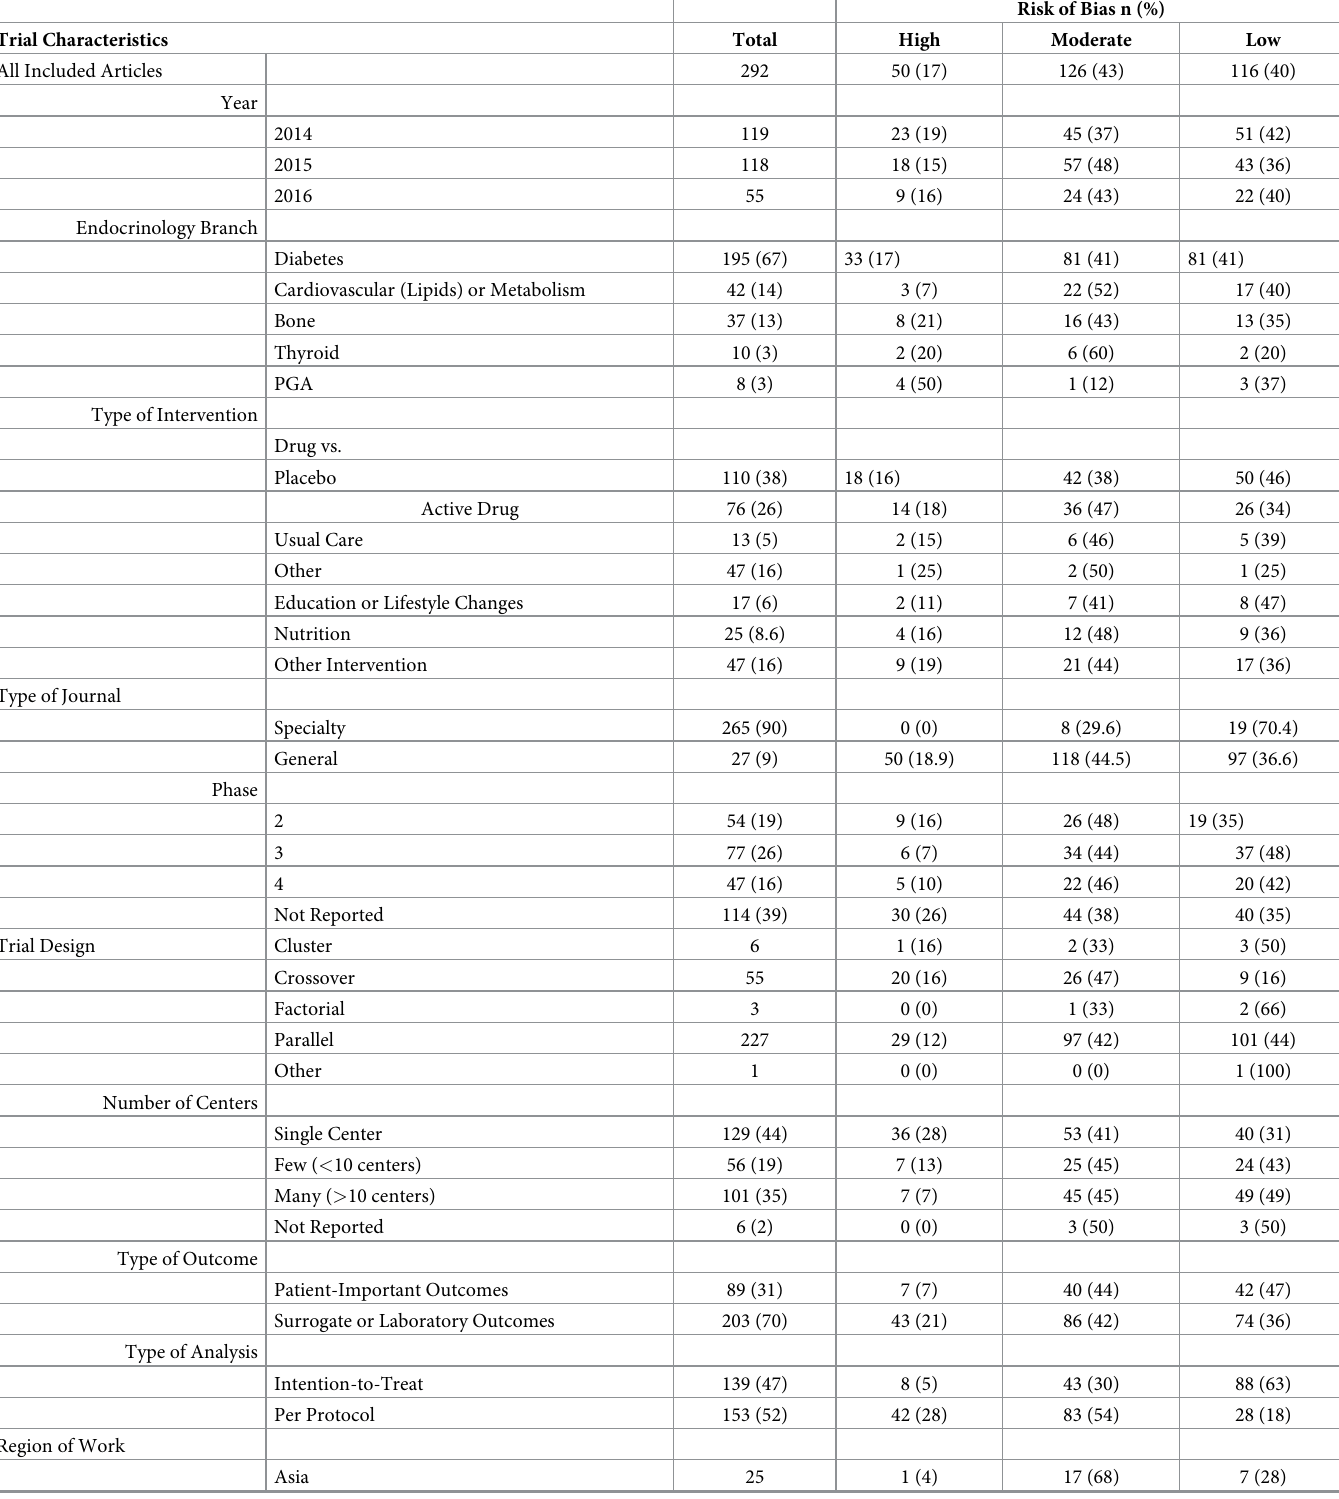
Table 1. Risk of bias of the 292 included randomized